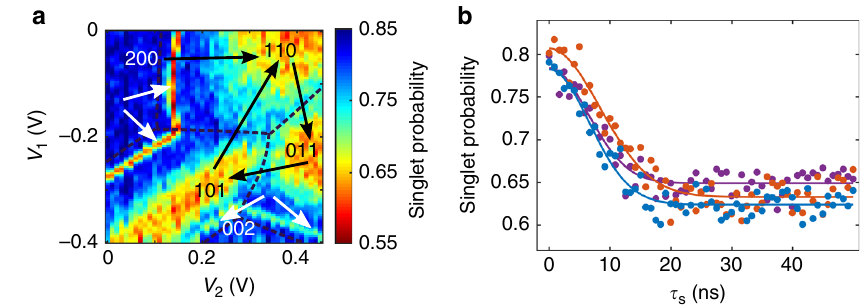
Fig. 2 Spin-mixing map and coherence without displacement. a Two-electron spin mixing map at B = 90 mT. From the position R in Fig. 1b, 50-ns pulses of amplitude V 1 and V 2 are simultaneously applied on V M,1 and V M,2 , respectively, before performing single-shot read-out of the two-electron spin states to extract the singlet probability. In the separated con fi gurations, S mixes with T 0 . In between two of these regions, one electron is exchanged between two dots and the spin mixing is less effective due to the increase of the exchange interaction (see Supplementary Note 3 and Supplementary Fig. 3). The arrows represent the ( V 1 , V 2 ) voltage pulses used to implement the separation and the displacement of the electrons and presented in Fig. 3a. The in fl uence of the tunnel-coupling on the spin-mixing map is discussed in Supplementary Note 5. b Singlet probability as a function of the time τ s spent in separated con fi gurations, where the electrons are static in (0, 1, 1), (1, 1, 0) and (1, 0, 1), ( orange , blue and purple , respectively). The data are fi tted with a Gaussian decay with a characteristic time T 2 * , respectively, equal to 9.0 ± 0.3, 9.9 ± 0.4 and 10.2 ± 0.4 ns